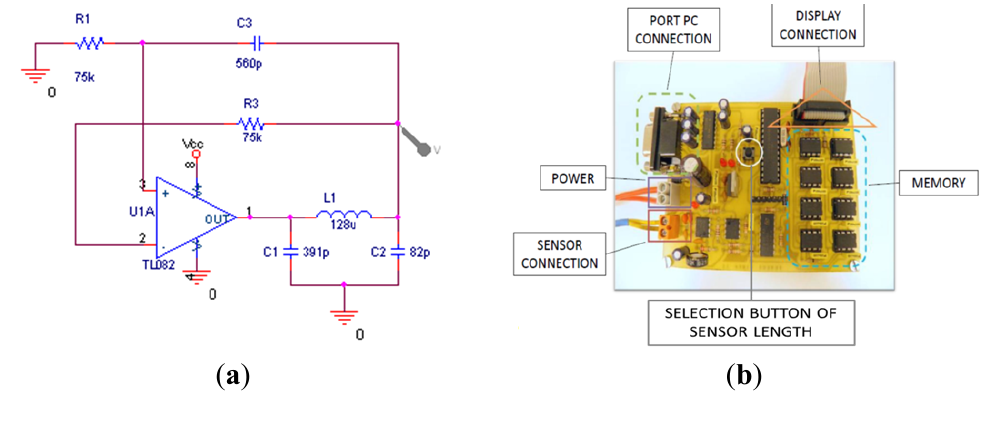
Figure 2. ( a ) General scheme of a Colpitts oscillator operating as an active element; ( b ) Developed electronic